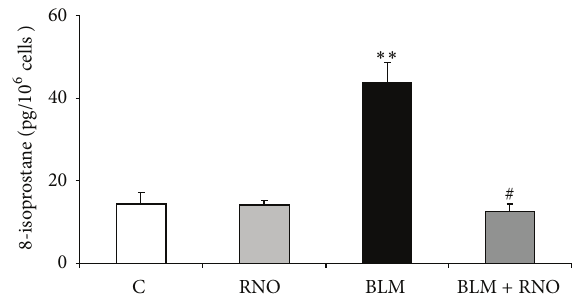
Figure 3: Effect of BLM and RNO on 8-epi-PGF 2𝛼 release in HLF. Levels of F 2 -isoprostanes (8-epi-PGF 2𝛼 ) were determined by an enzyme immunoassay kit in the media of HLF from 3 donors treated with BLM (50mU/mL) for 24 h, in presence or absence of RNO (2nM). Data are mean ± SD of 3 experiments. ∗∗ 𝑃 < 0.001 versus control (C); # 𝑃 < 0.05 versus BLM.